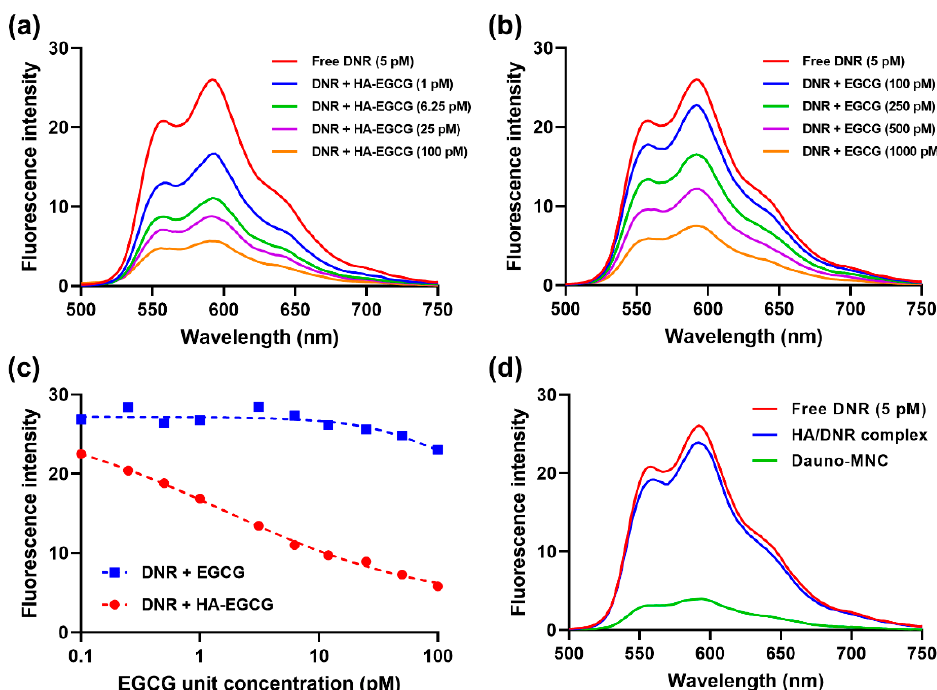
Figure 3. ( a , b ) Fluorescence emission spectra ( λ ex = 480 nm) of DNR solution (5 pM) mixed with various concentrations of ( a ) HA–EGCG or ( b ) native EGCG. ( c ) Comparison of the fluorescence quenching effect of HA–EGCG and EGCG ( λ em = 592 nm). ( d ) Fluorescence emission spectra of Dauno-MNC, HA/DNR complex and free DNR at an equal concentration (5 pM).